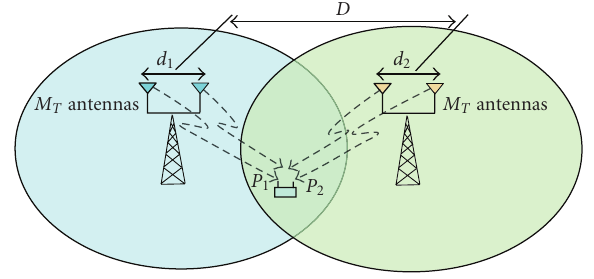
Figure 1: SFN with unequal received